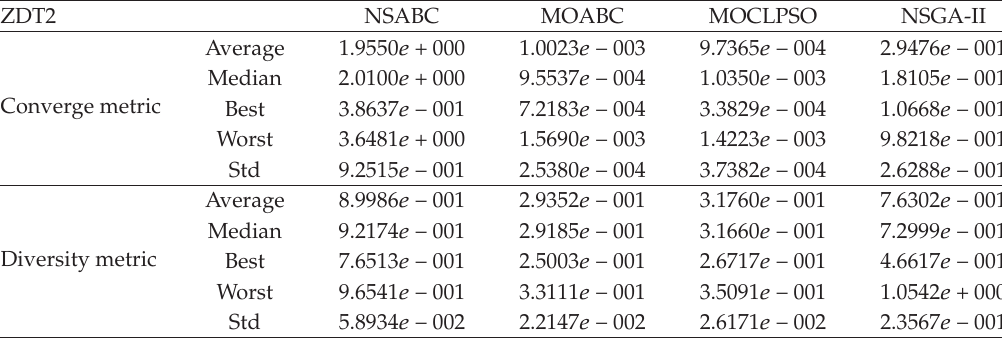
Figure 16: Pareto fronts obtained by NSABC, MOABC, MOCLPSO, and NSGA-II on DTLZ2 after 20000 FEs. Table 7: Comparison of performance on ZDT2 after 10000